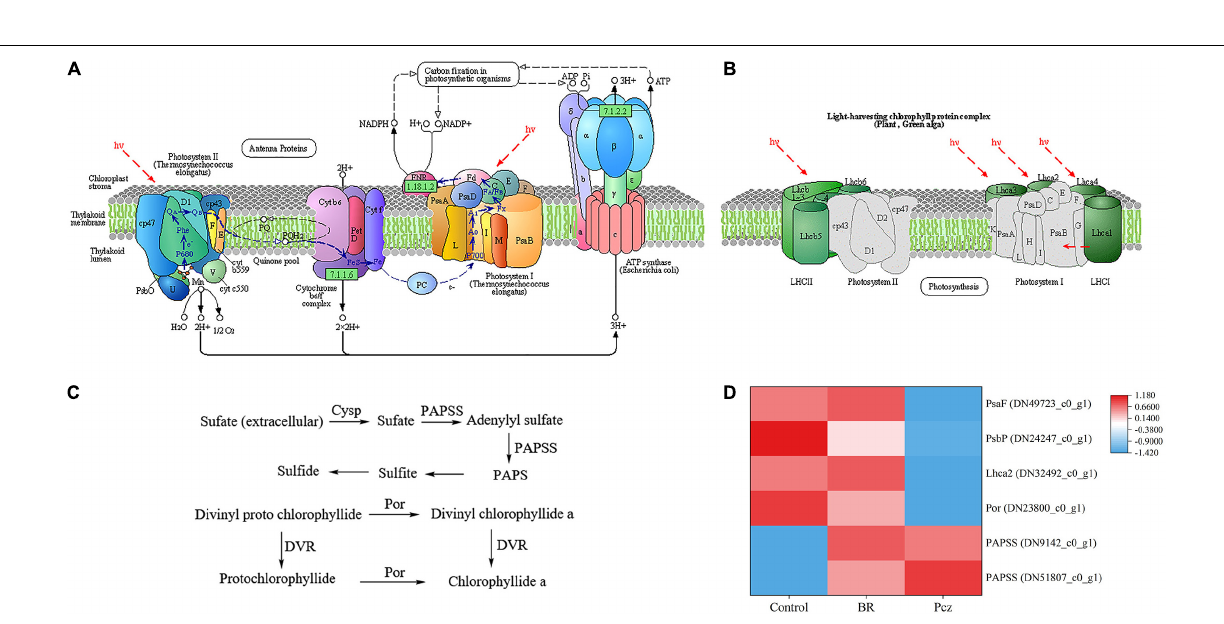
Frontiers in Plant Science |